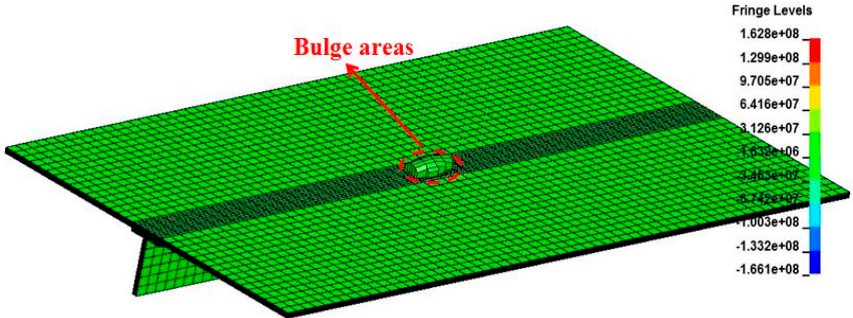
Figure 15. Overall pressure contours of the composite reinforced panel.